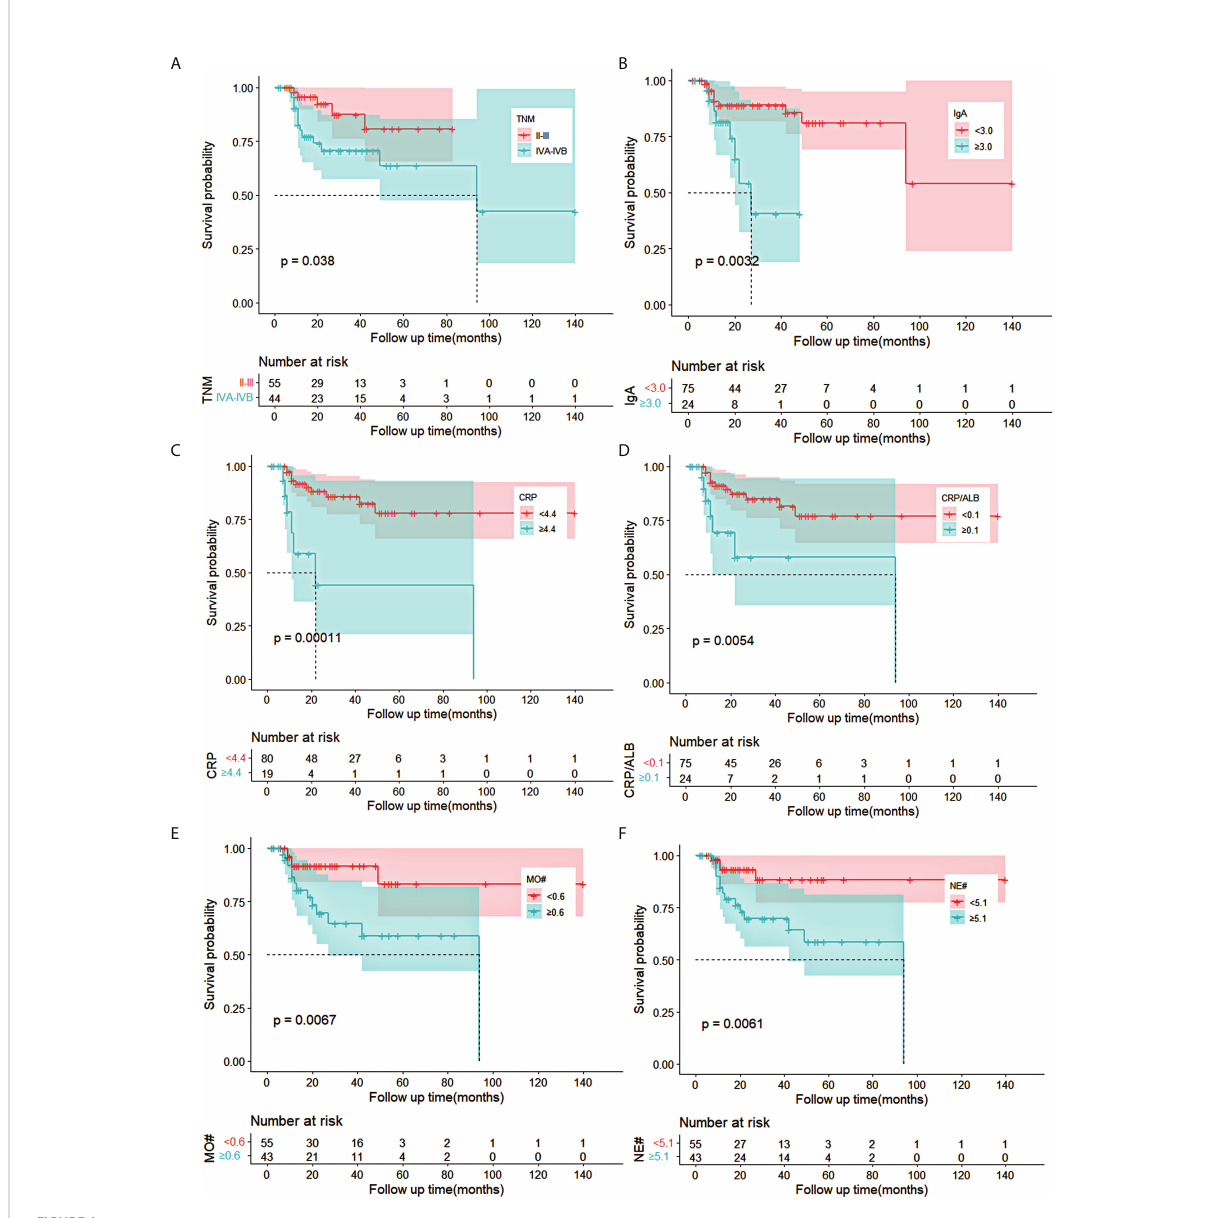
FIGURE 1 Kaplan – Meier curves for OS in ESCC patients receiving nCRT plus surgery in training cohort. (A – F) The survival curves of clinical TNM stage, IgA, CRP, CRP/ALB, MO#, and NE# in ESCC patients. OS, overall survival; ESCC, esophageal squamous cell carcinoma; nCRT, neoadjuvant chemoradiotherapy; IgA, immune globin A; CRP, C-reactive protein; ALB, albumin; MO#, absolute count of monocytes; NE#, absolute count of